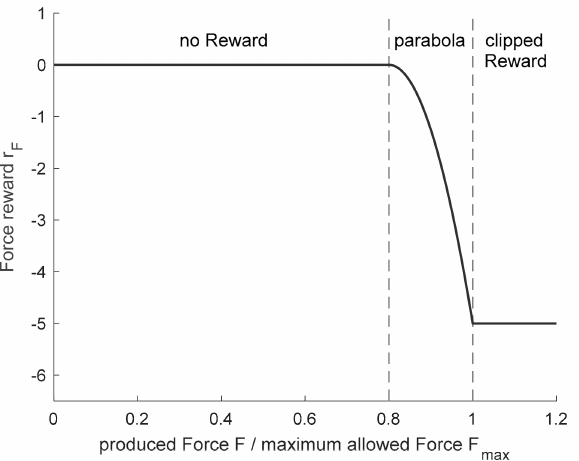
Figure A1. Plot of the Force reward, r F , over the ratio of the produced force, F , and the maximum allowed Force, F max , in case the current height, h , is equal or lower than the maximum final height h f , ub , and thus the related state, s , is a terminal state, s + .